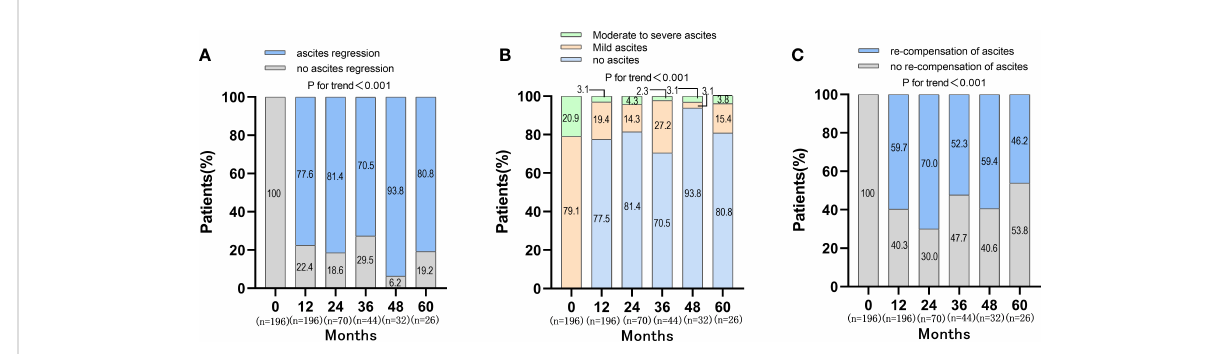
FIGURE 2 Changes of ascites and re-compensation of ascites in patients with fi rst decompensated HBV cirrhosis of ascites after NUC treatment. (A) Changes of ascites in patients after NUC treatment at baseline, 12, 24, 36, 48 and 60 months; (B) Distribution of ascites severity in patients after NUC treatment at baseline, 12, 24, 36, 48 and 60 months; (C) Re-compensation of ascites in patients after NUC treatment at baseline, 12, 24, 36, 48 and 60 months.